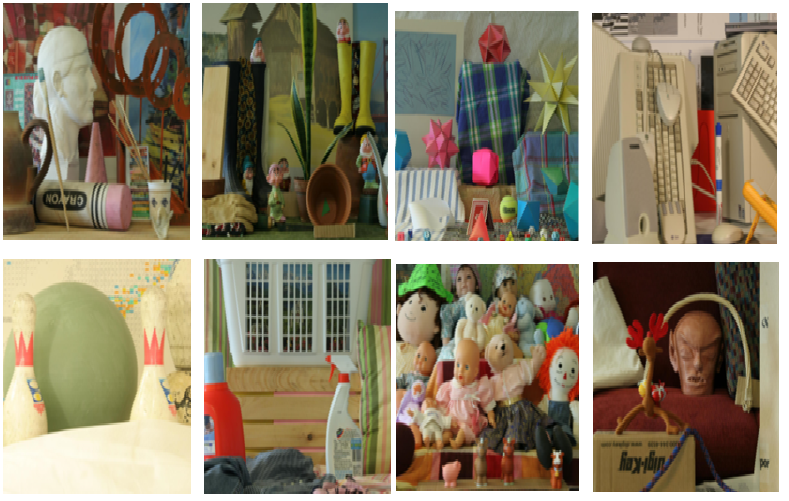
Figure 3. Ningbo image database.